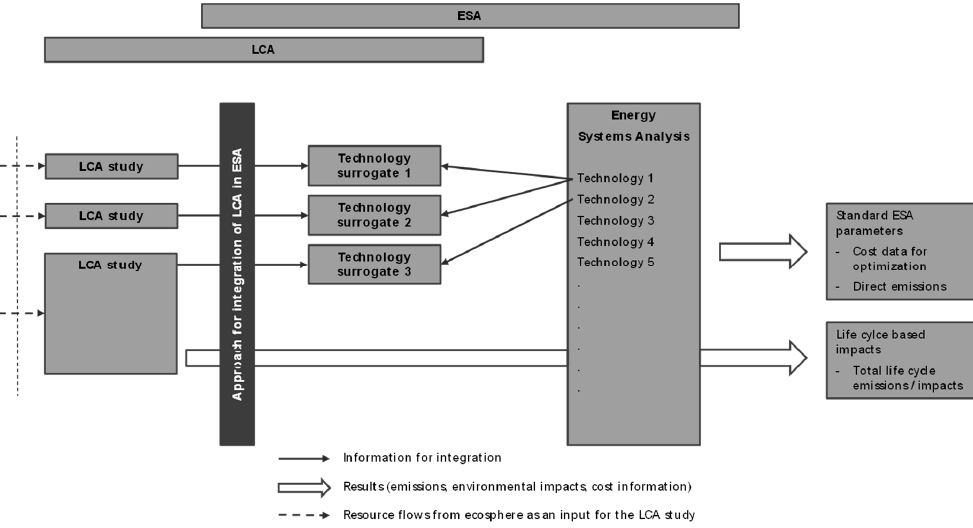
Figure 3. Schematic flow chart of the adjustment of LCA models for the adoption to